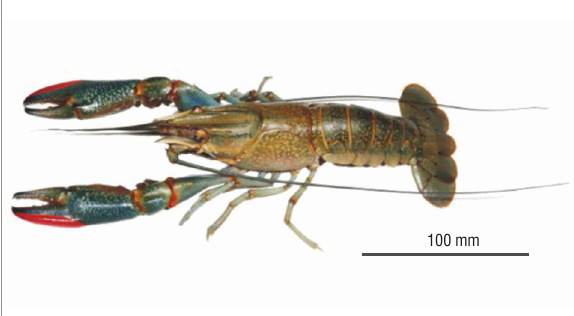
A male Cherax quadricarinatus specimen collected in the Ndumu Game Reserve, KwaZulu-Natal.